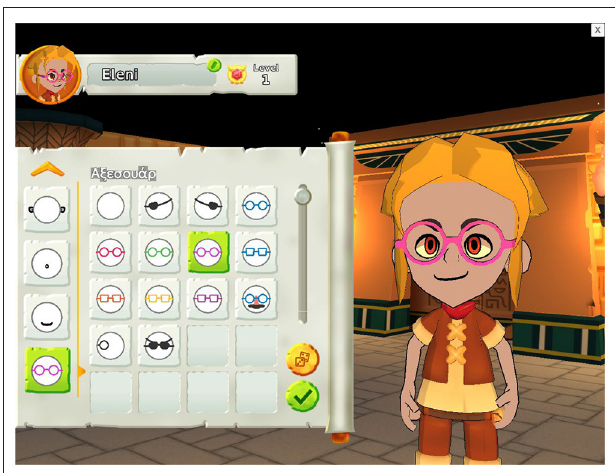
FIGURE 3 | The ability to personalize their avatar has been shown to increase rapport in users ( Mavrikis et al.,